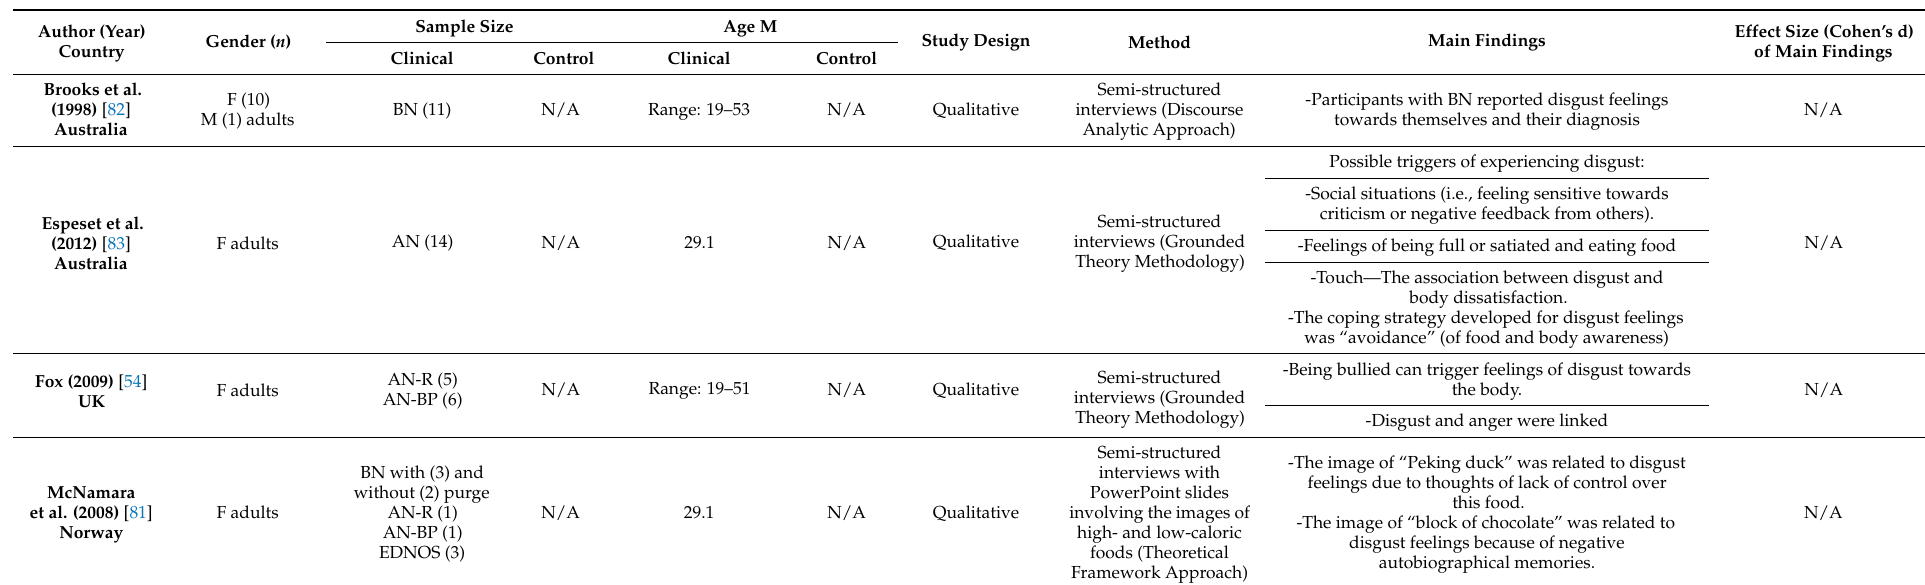
Table 5. A Summary of qualitative studies in